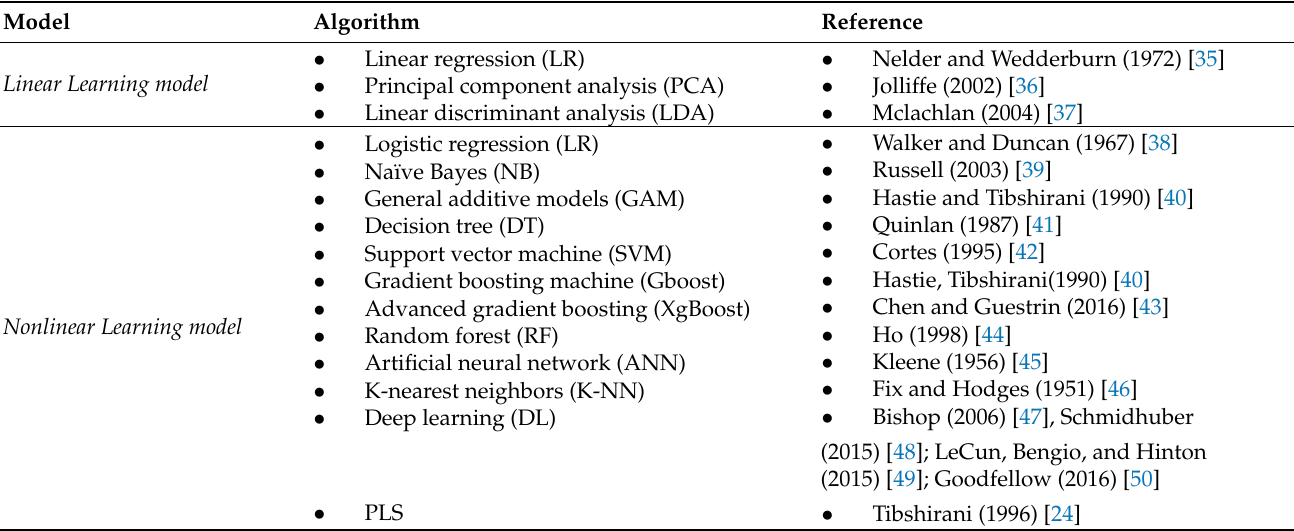
Table 2. List of the most commonly used machine learning algorithms in medical imaging.